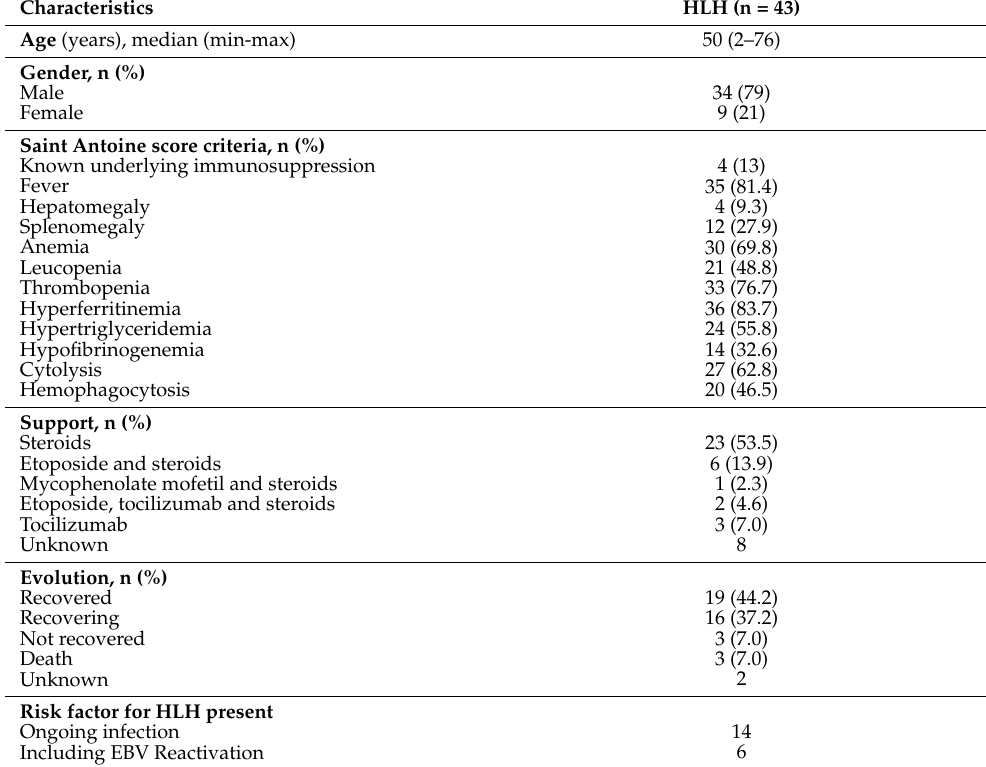
Table 2. Clinical description of ICI-induced HLH reported in the French pharmacovigilance database (n = 30) and the literature (n =